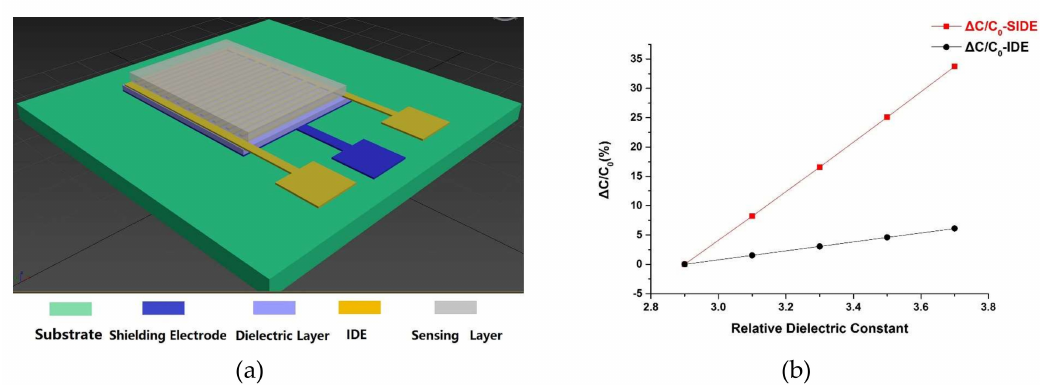
Figure 2. SIDE structure and simulation results. ( a ) 3D model of SIDE structure; ( b ) Comparison of the relative changes in capacitance of the SIDE ( red line ) and IDE ( black line ) structure according to numerical simulations.